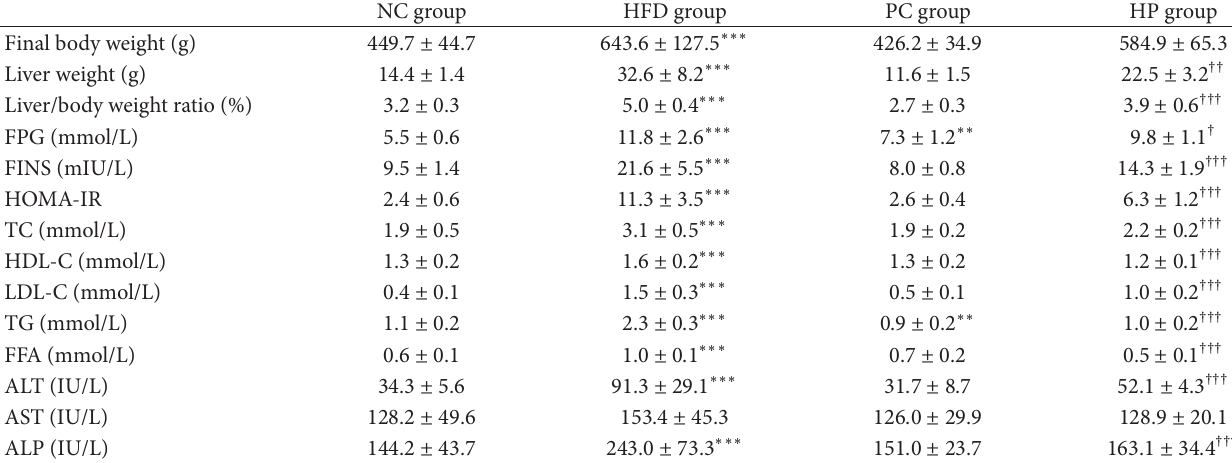
Table 1:Data for bodyweight, liver weight, and biochemical parameters inthenormalcontrol (NC),high-fat diet(HFD), pioglitazone control (PC), and high-fat diet plus pioglitazone (HP)